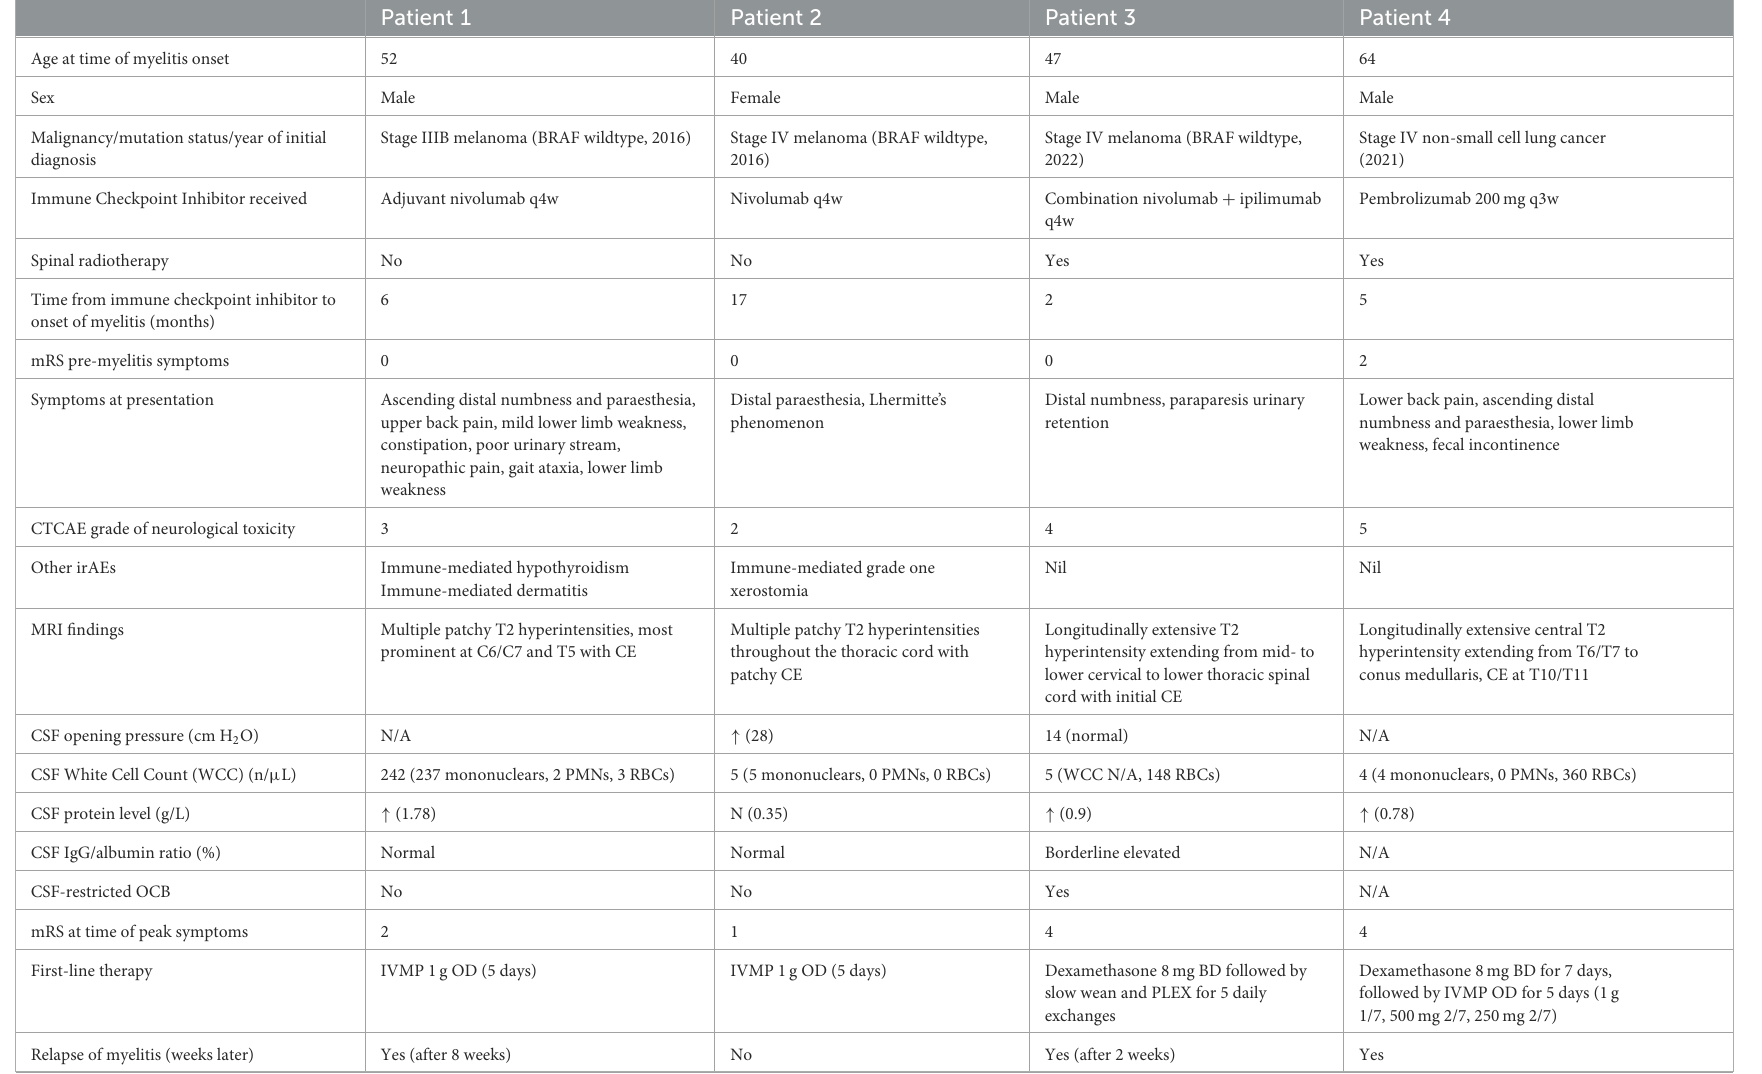
TABLE 1 Comparison of the clinical manifestations, investigations and prognosis for each